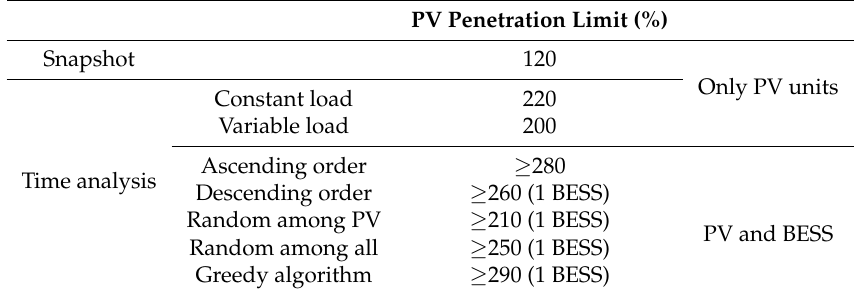
Table 6. Comparison of PV hosting capacity for different scenarios (with vs. without